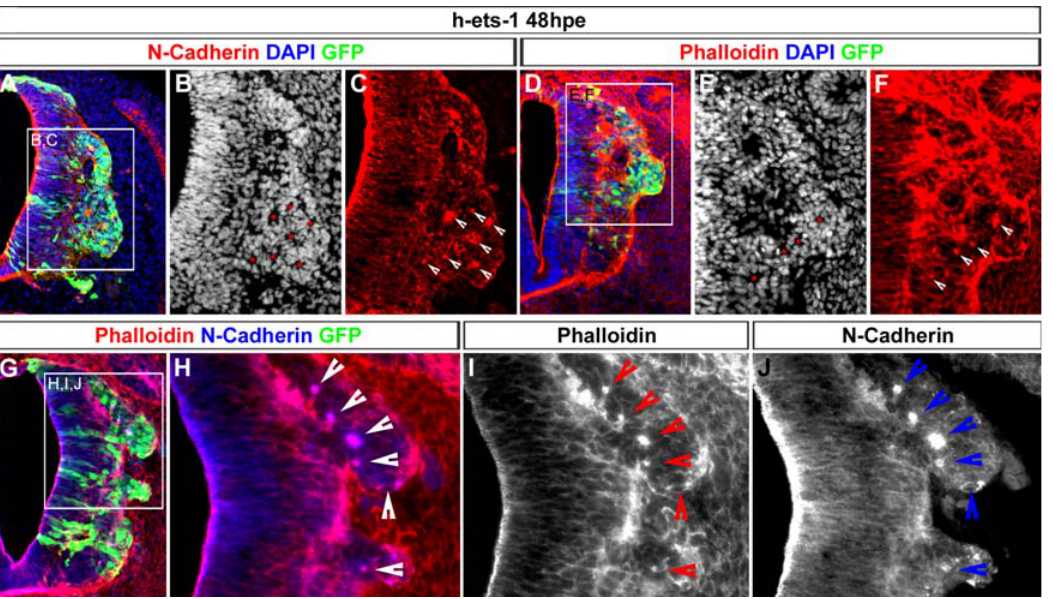
Figure 9. Ectopic Electroporated Cells Are Still Attached by Functional Cell-Cell Junctions. (A–J) Analysis of the effects of h-ets-1 misexpression in intermediate to ventral neural tube at 48hpe. Transversal cryosections (10 m m) labeled by immunofluorescence with anti-N-Cadherin antibody (A–C, red; G–J, blue). Actin microfilaments and nuclei are stained with Phalloidin (D–I) and DAPI incorporation (A–F) respectively. Electroporated cells detected by GFP expression (A, D, G) are organized around dots of high N-Cadherin expression (A–C, red dots, white arrows) or high Phalloidin staining (D–F, red dots, white arrows). N-Cadherin and Phalloidin perfectly match to each other (G–J, arrow heads) indicating that N-Cadherin expressed by the electroporated cells is involved in functional cell-cell junctions.